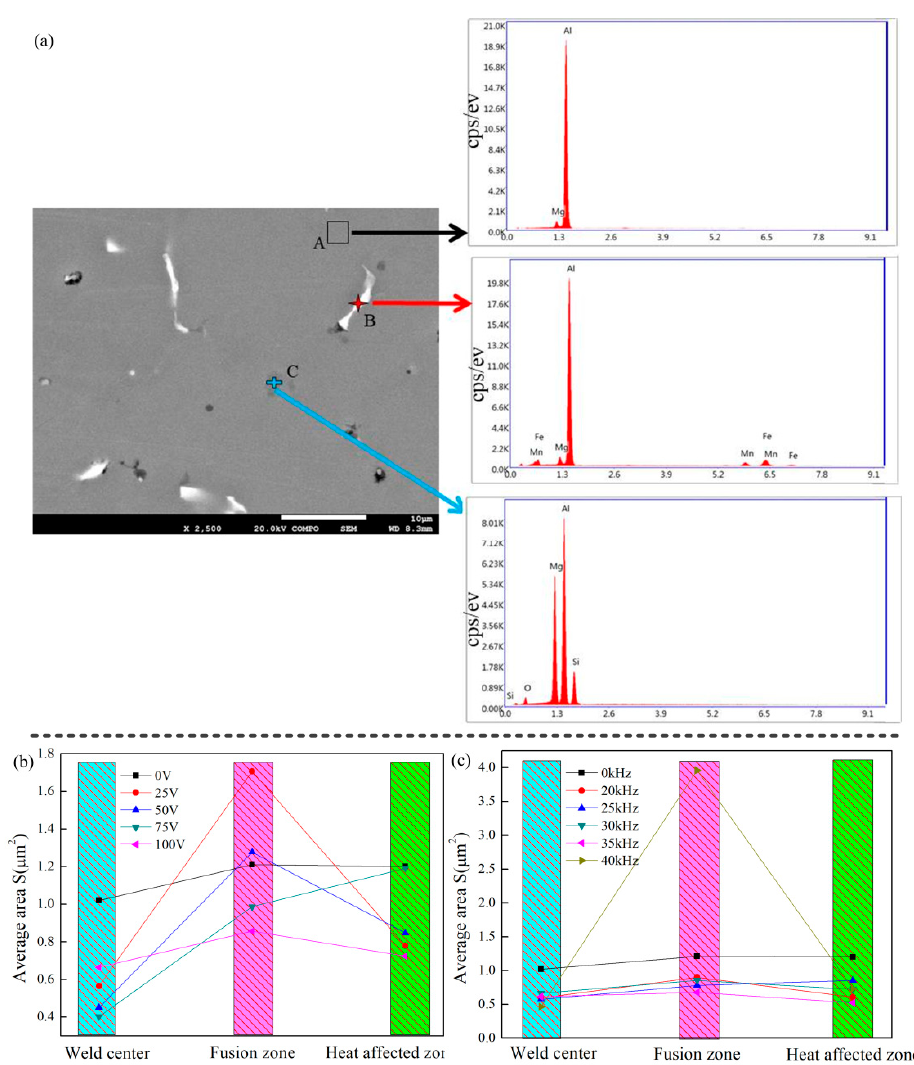
Figure 7. ( a ) SEM and EDS analysis on the second phase composition; The second phase size from different ( b ) ultrasonic excitation voltage, and ( c ) ultrasonic excitation frequency.